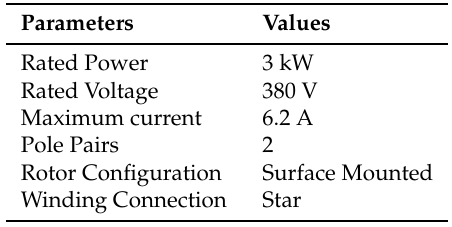
Table 2. Parameters of the motor in the test.